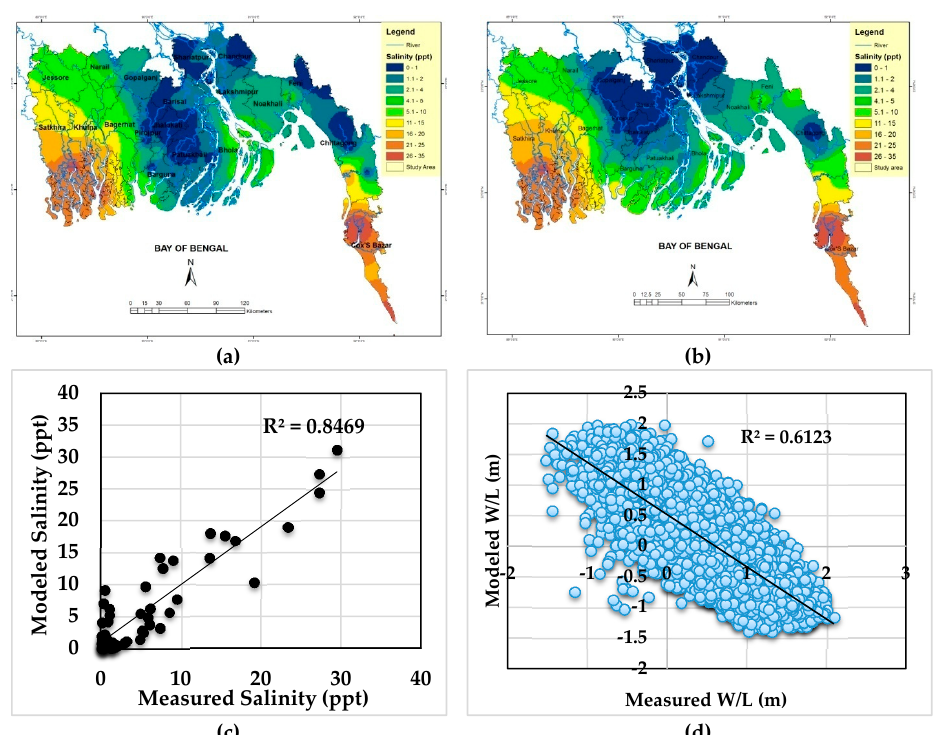
Figure 2. Calibration result of salinity model that shows comparison of maximum salinity values and water level in one location in the study area during the year 2011. The result shows (a) measured and (b) modeled simulated salinity values in ppt . (c) Measured salinity vs. modeled salinity and (d) measured water level vs. modeled water level.